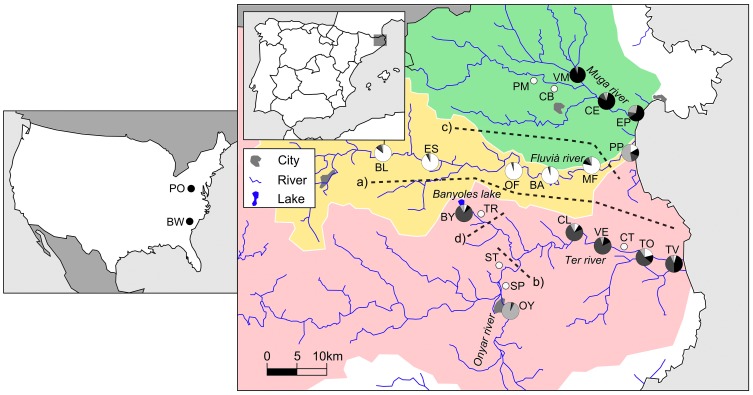
Geographical location of the collection sites.Sampled sites where G. holbrooki was not found are indicated with empty circles. Grey-scaled pie charts (white, light grey, dark grey, and black) represent mean proportional ancestry of every sampled site attributed to each cluster inferred by STRUCTURE. Watersheds are colored. Dotted lines represent geographical barriers indicated by BARRIER and the letters indicate the order in which the program detected these barriers. Location codes are presented in Table 1. (A detailed map with information about the road network is available at: http://mapsengine.google.com/map/viewer?mid=zgd4mwb-ESLE.kSE9TUfF2uQ4).